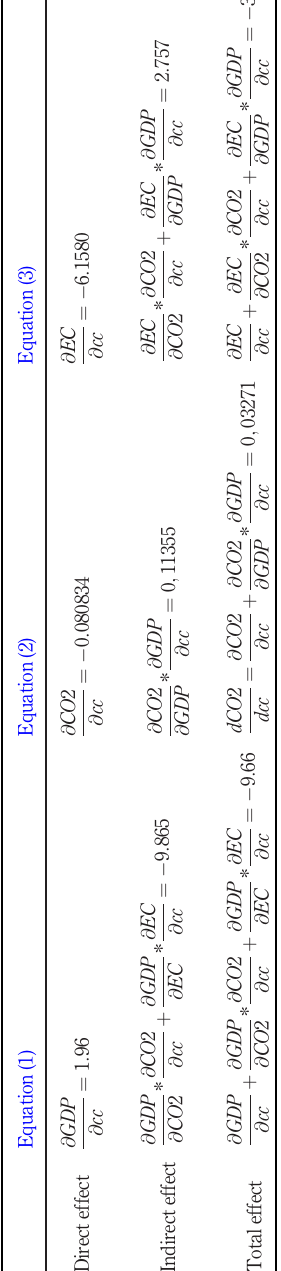
Table V. Decomposing the impact of corruption on pollution, growth and